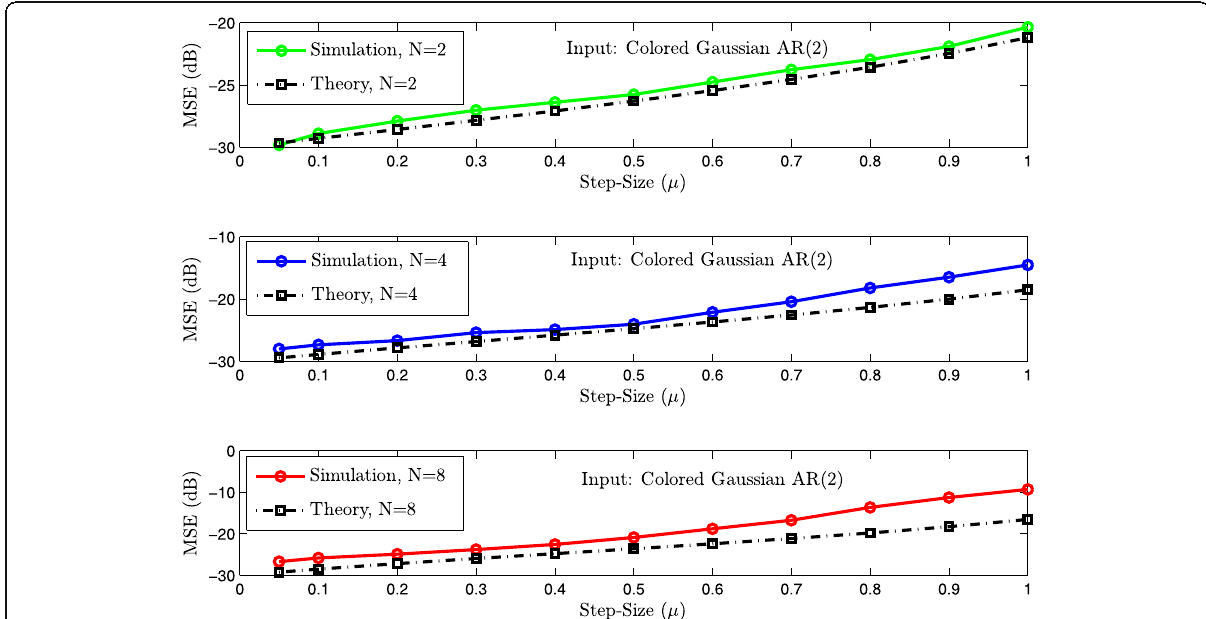
Fig. 26 Simulated and theoretical steady-state MSE of SR-NSAF with N = 2, 4, and 8 as a function of the step-size